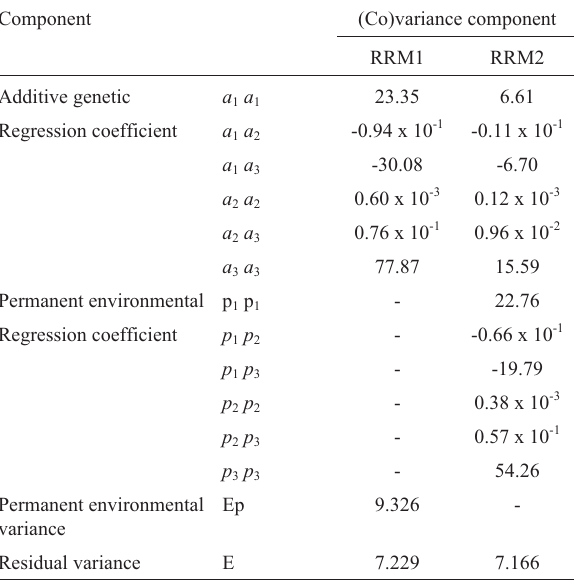
Table 4 - Estimates of genetic and permanent environmental (co)vari- ances of the random regression coefficients and permanent environmental and residual variances obtained by the RRM1 and RRM2